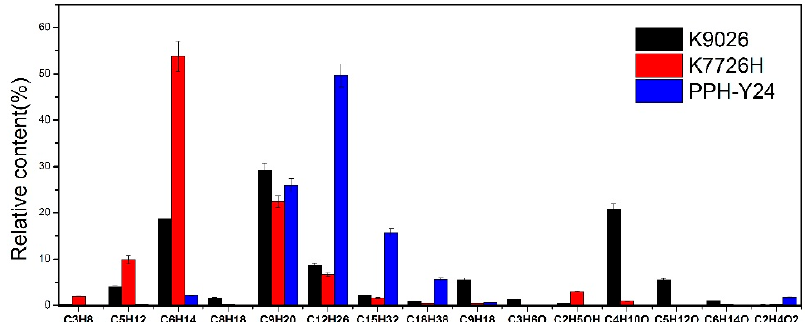
ff erent polypropylene